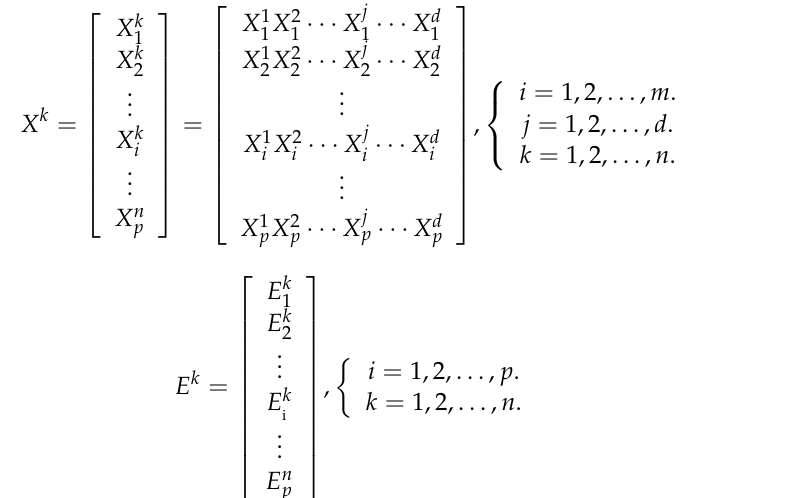
Figure 2. Position determination of electrons (solution candidates) with PDF distribution: ( a ) Position of electrons; ( b ) Distribution of electrons.